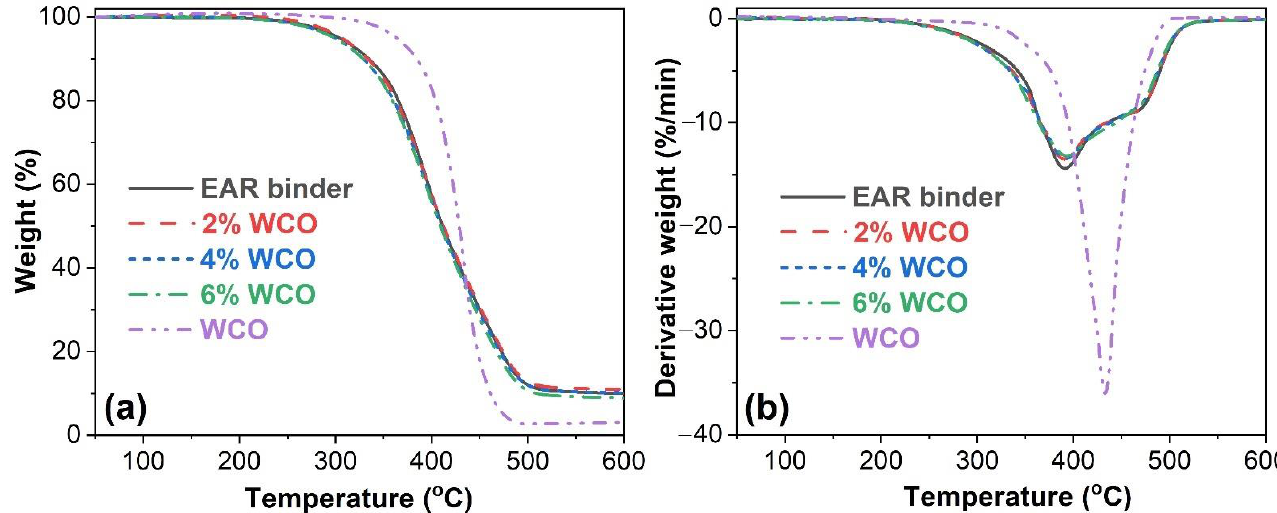
Figure 2. ( a ) TGA and ( b ) DTG curves of WCO and the unmodified and WCO-modified EAR bind- ers. Table 1. Thermal parameters of WCO and the unmodified and WCO-modified EAR binders. WCO (%)